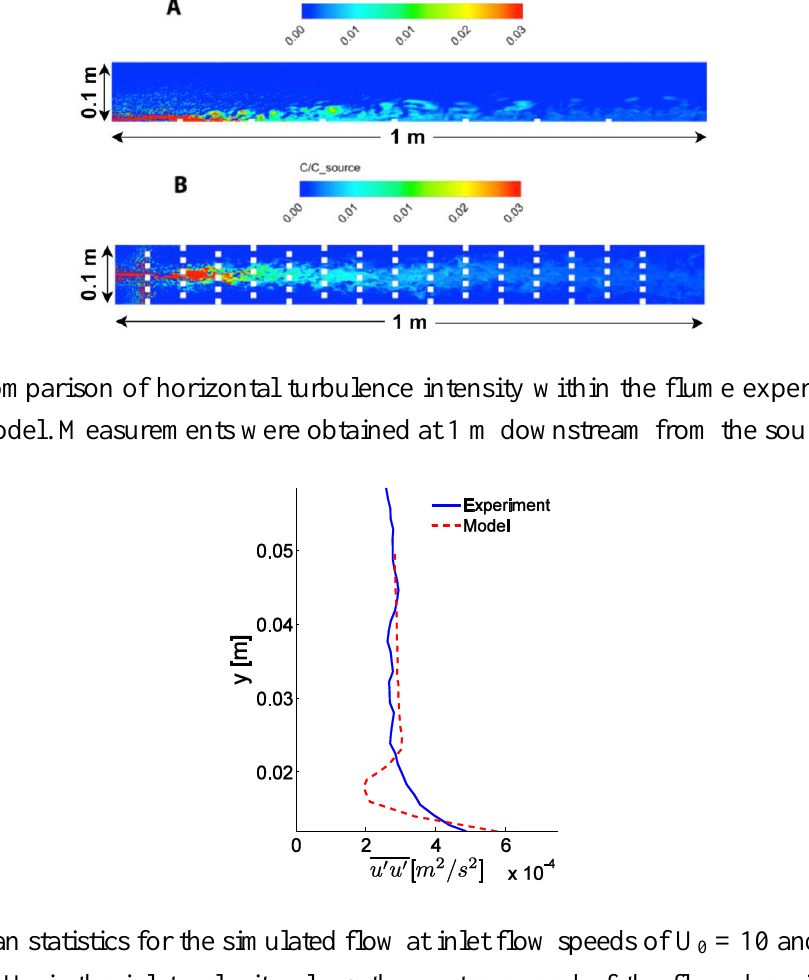
= 10 and 15 cm s −1 0